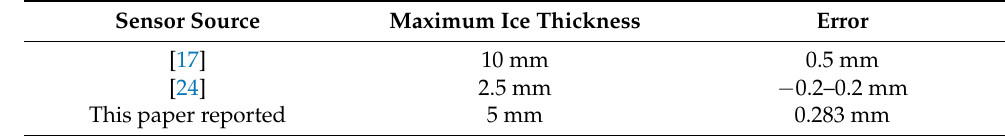
Table A1. Comparison of the sensors reported in this paper and those in [17,24]. Sensor Source Maximum Ice